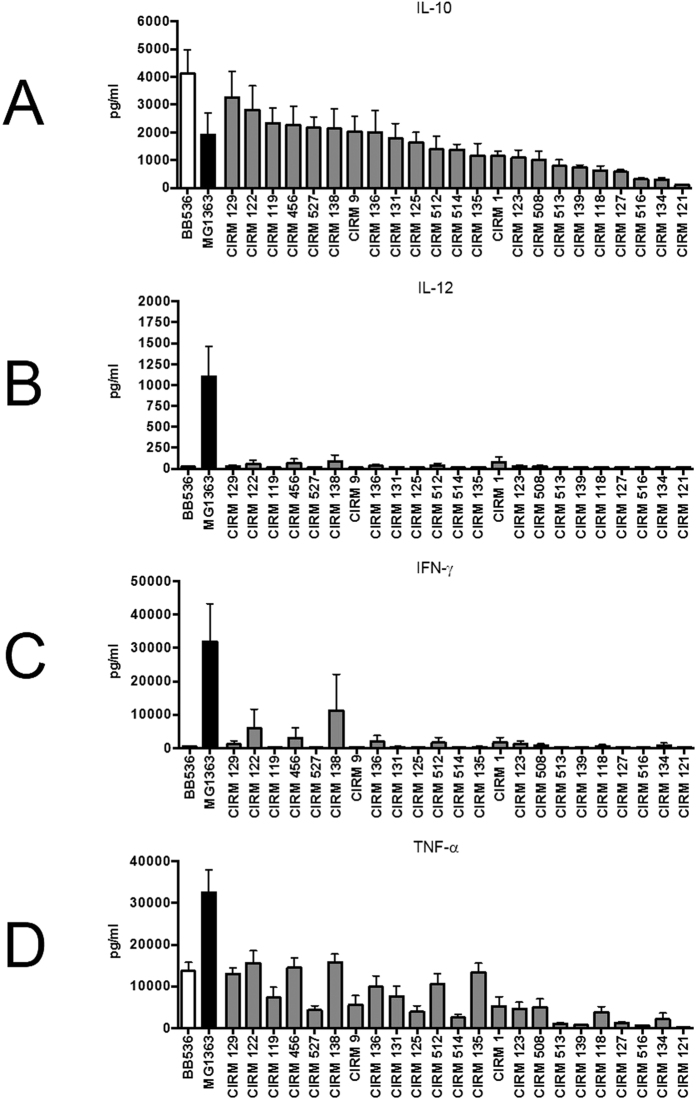
In vitro immunomodulatory phenotypes of Propionibacterium freudenreichii strains grown on dairy-based culture medium.Comparative anti-inflammatory (A) IL-10 and pro-inflammatory (B) IL-12, (C) IFN-γ and (D) TNF-α cytokine responses of human PBMCs stimulated by Pf strains or by the positive controls Lactococcus lactis MG1363 and Bifidobacterium longum BB536 (pro- and anti-inflammatory strains, respectively). All bacterial strains were implemented at a bacterial density corresponding to a multiplicity of infection (MOI) of 10, and the supernatants collected were analysed using ELISA. Immunocompetent PBMC cells were stimulated by bacteria for 24 h and the data are expressed in pg/ml as means +/− SEM of the results concerning four separate french healthy blood donors. The Pf strains are ordered by their decreasing induction of IL-10, which is highly variable.